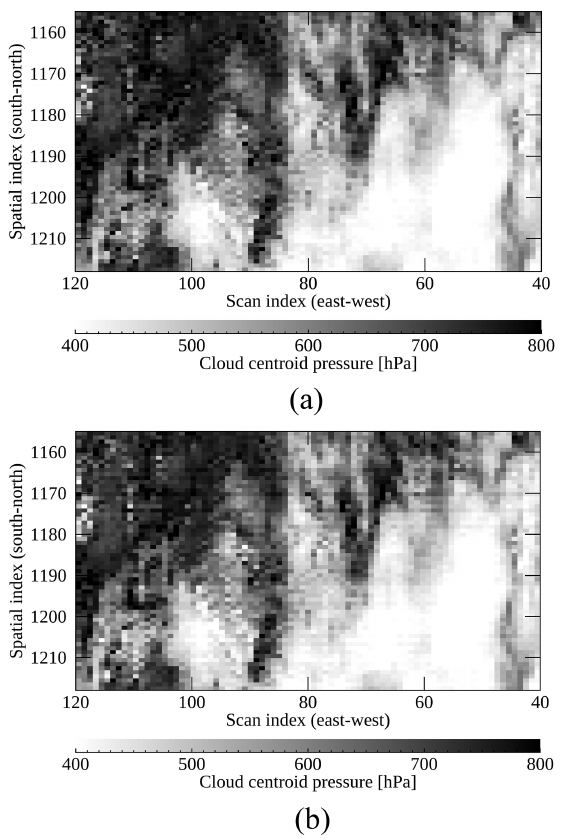
Figure 12. Spatial distribution of cloud centroid pressure retrieved with (a) GEMS and (b) ML radiances zooming in on a certain area presented in Fig. 7. The GEMS spectra were measured on 10 March 2021 (06:00UTC).